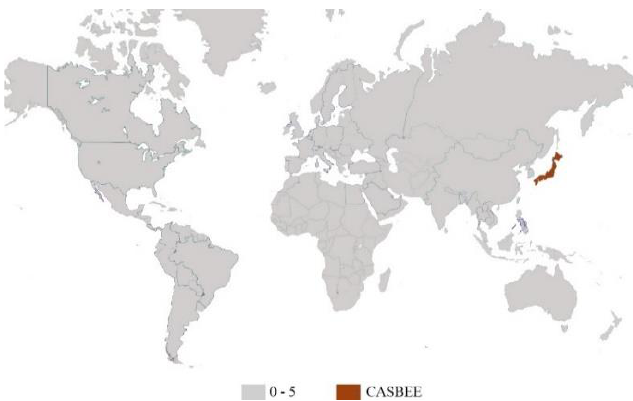
Fig. 5. Countries with CASBEE certificates in the world and the number range [Created by the authors based on CASBEE